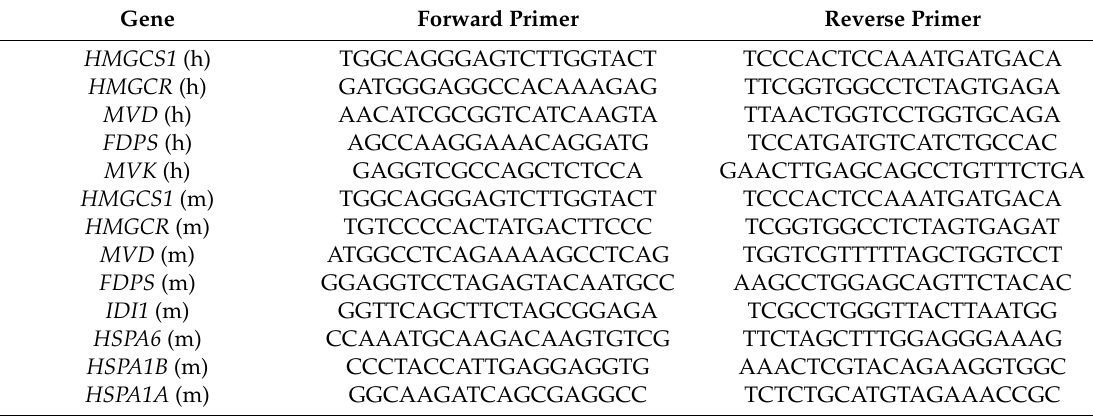
Table 1. Primer sequences for